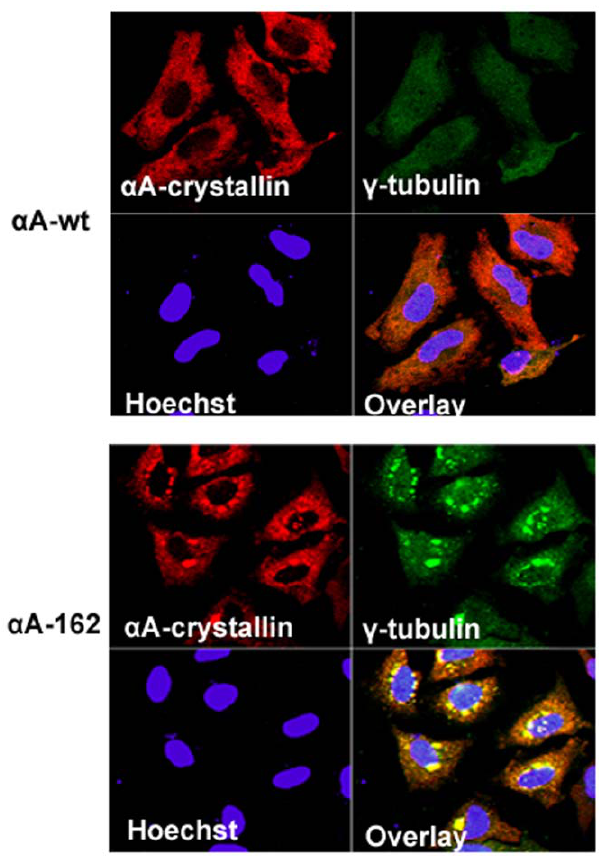
Figure 12. Inclusion bodies containing truncated a A-crystallin are aggresomes. After 48 hours transfection, cells were double immunostained with a A-crystallin (Red) and c -tubulin (green). The co- localized (yellow) perinuclear signals characterize positive for aggre- somes only in the truncated a A162 expressing cells. c -tubulin did not co-localize in cells expressed with a AWT. Cells were counterstained with Hoechst 33342, allowing the detection of nuclei (blue).